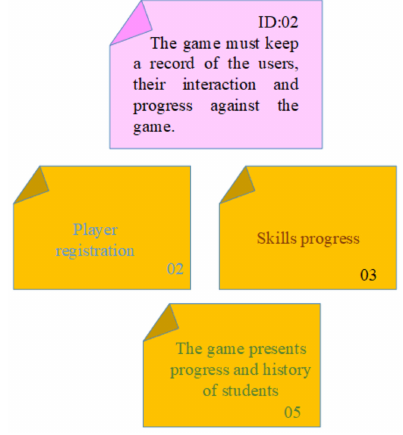
Figure 11. Desired and General Purposes.